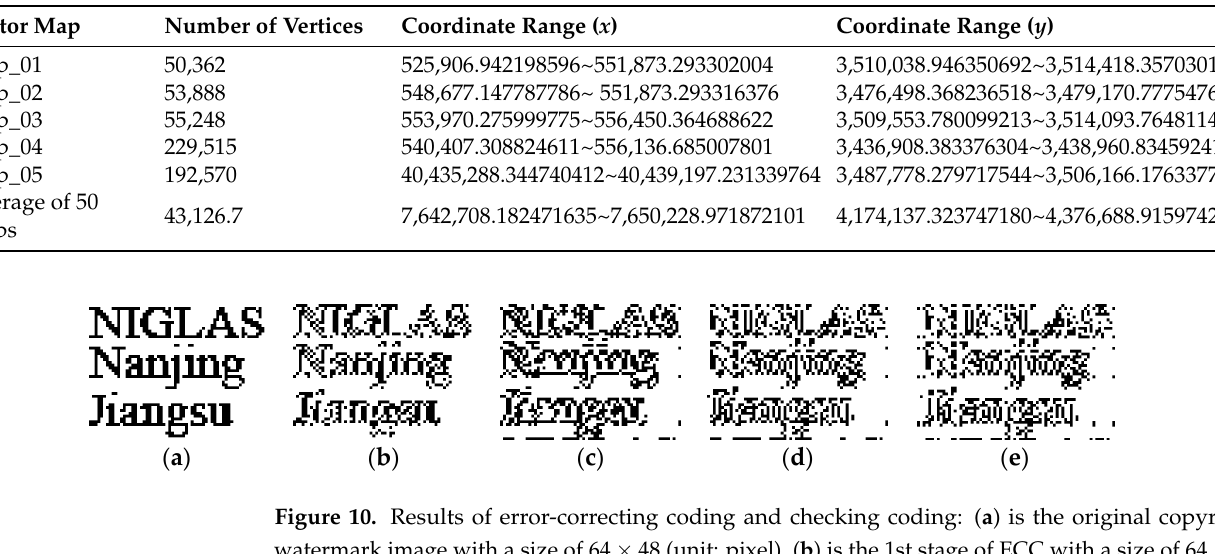
Table 4. Properties of the fifty adopted experimental vector maps.